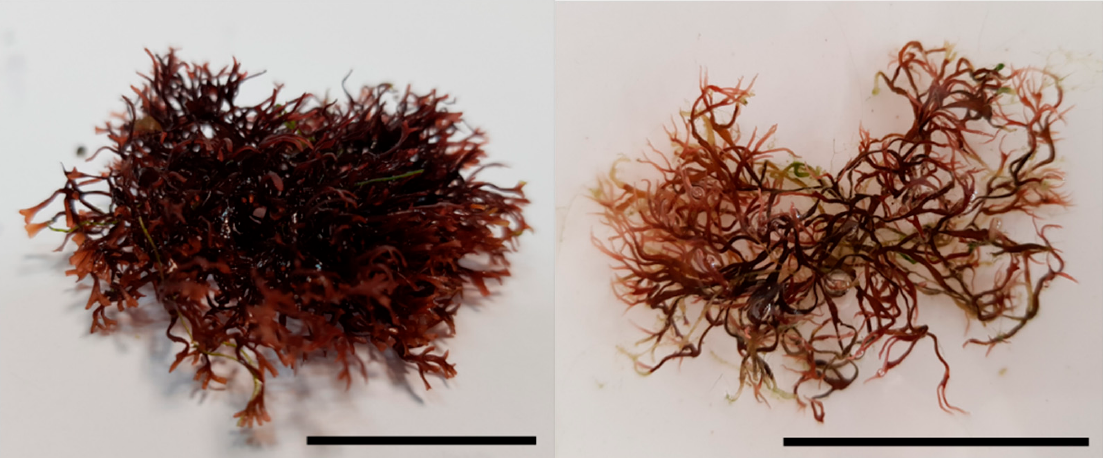
Figure 2. Coccotylus brodiei collected in Puck Bay in 2019. The line represents a distance of 5 cm.